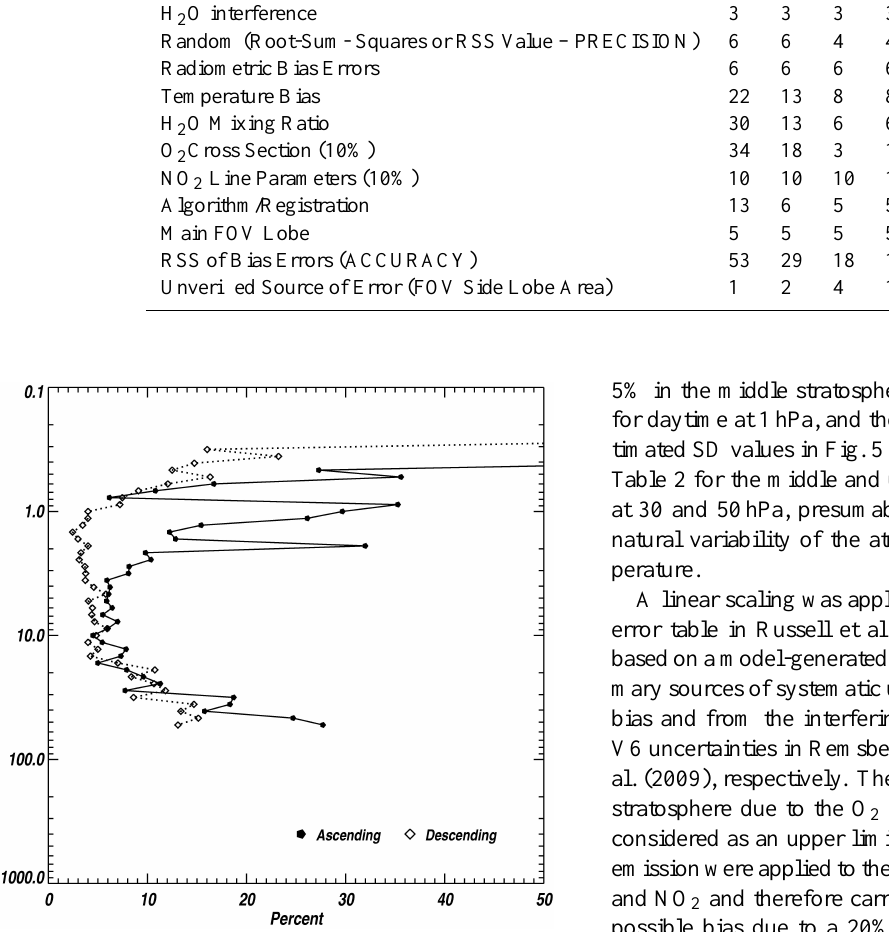
Random (Root-Sum- Squares or RSS Value – PRECISION)